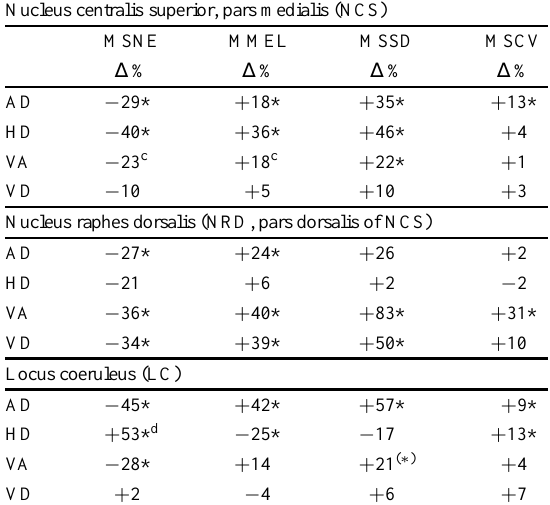
Analysis of variance with the General Linear Models procedure with MST variables for Alzheimer disease (AD) versus controls